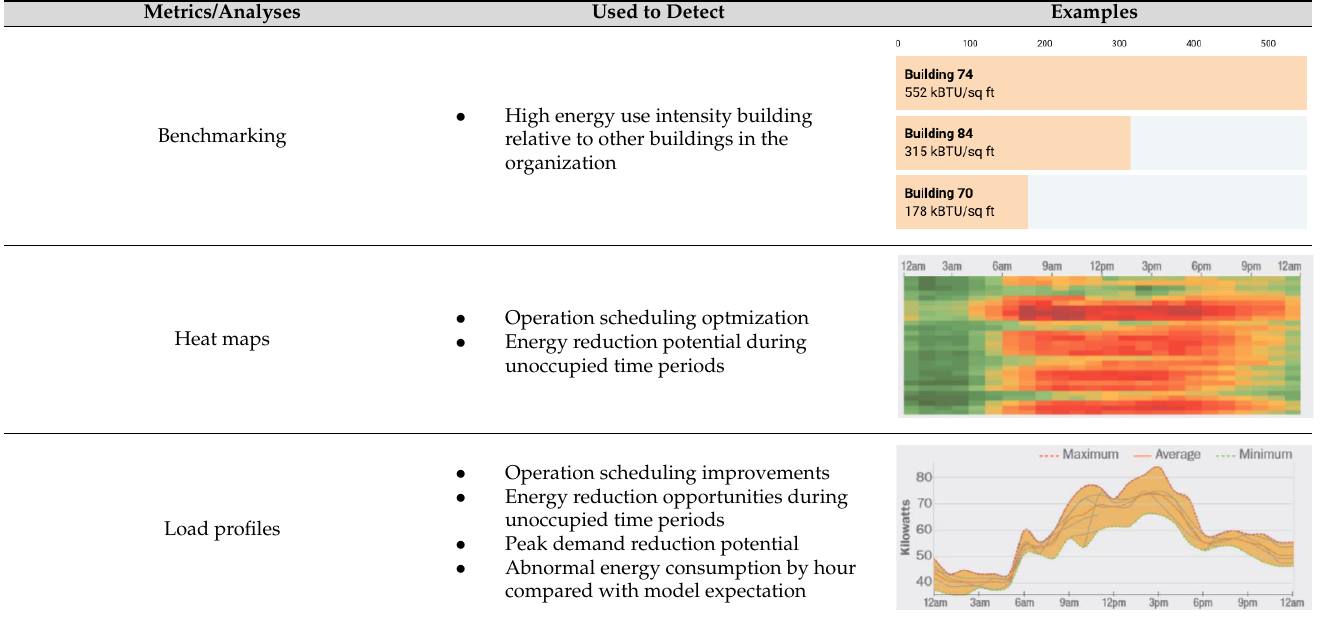
Table 7. Common faults or opportunities identified by FDD tools.